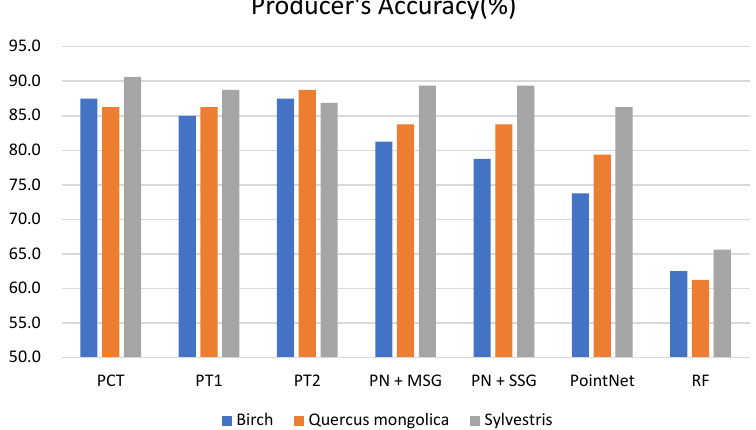
Figure 11. PA (producer’s accuracy) bar chart of seven algorithm calculated from confusion ma- trix.